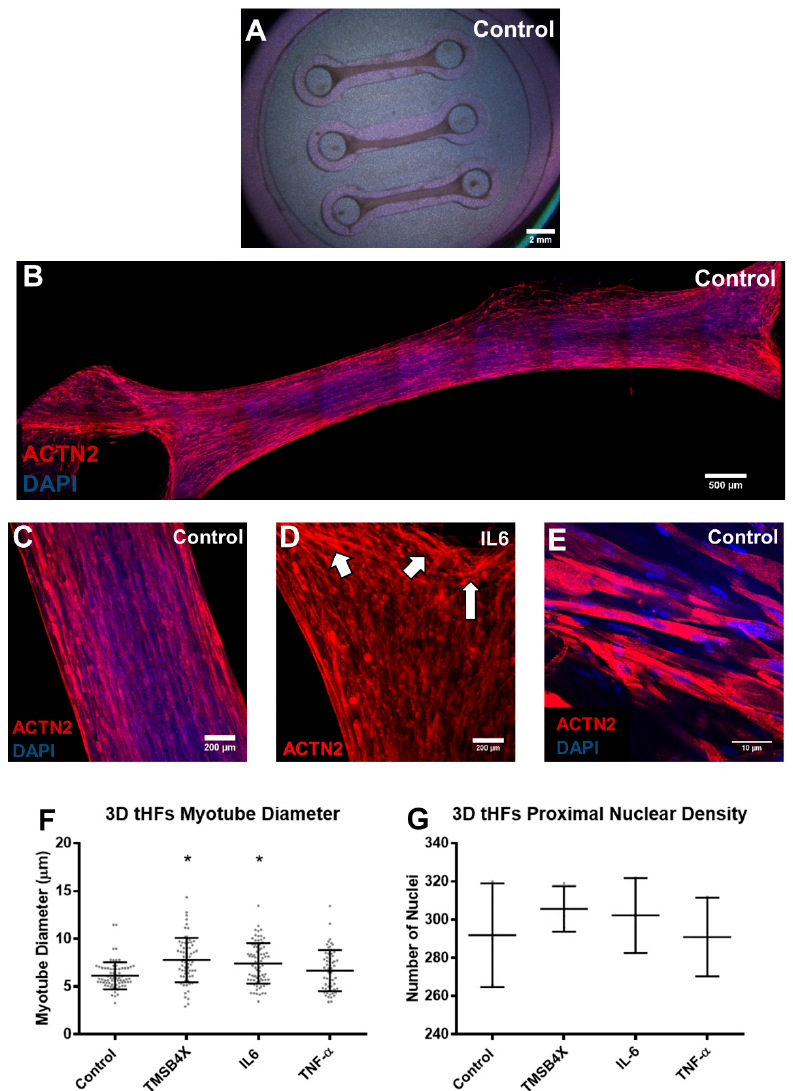
Figure 6. Exposure of fibrin-based engineered skeletal muscle 3D tissues derived from tHFs to biological ligands TMSB4X, IL6, and TNF- α . The transdifferentiation of HFs was initiated through the transduction of MYOD1 gene segments, encapsulated in a fibrin-based hydrogel, and plated on a PDMS mold with attachment pillars, to help develop tension within tissues. The introduction of Dox and SB instigated transdifferentiation and was sustained for a week, followed by the administration of 10 ng/mL ligands TMSB4X, IL6 or TNF- α for an additional 7 days. ( A ) Low magnification stereomicroscopy of PDMS mold, holding three microwells bearing tissues and tensile force forming around pillars, image captured on day 14 of experimentation. ( B ) Tissue-engineered tHFs were stained with Sarcomeric ACTN2, and nuclear DAPI; images were stitched at low magnification to display compact, aligned skeletal muscle cells condensed in a tissue. ( C ) Elongated, multinuclear myotube formation along the axis of the tensile force. ( D ) Cells formed condensed layers at PDMS pillars due to gradual contraction of hydrogel and accumulation of extracellular matrix. Arrows indicate condensed layers forming around pillar due to hydrogel contraction and extensive tensile force from cell-produced ECM. ( E ) High magnification skeletal myotubes show limited cross-striated cells and suggest partial compactness. ( F ) Characterization of skeletal myotube development was evaluated with diameter ( µ m) quantification at various cross-sectional Z-stacks ( n > 60, mean + SD, “*” denotes significance p < 0.05 against control). ( G ) Total number of nuclei were identified for each condition and tallied for the entire cross-section of a proximal localization on the tissue. ( n = 6, mean + SD, “*” denotes significance p < 0.05 against